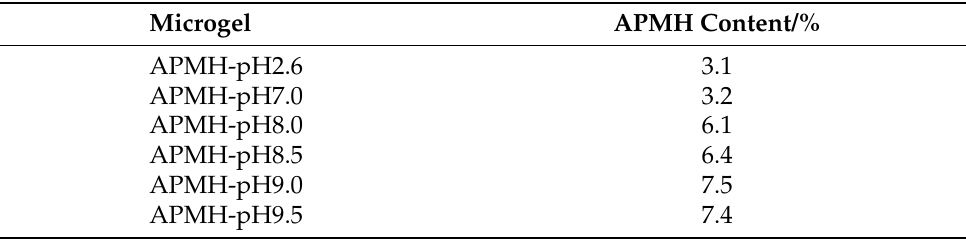
Figure 11. 1 H-NMR spectra of microgel APMH-pH2.6 and -pH9.5 in H 2 O/D 2 O. With increasing pH, a change in APMH-signals is visible. All spectra are given in the Supplementary Material. Table 4. APMH content in the microgels relative to the amount of NIPAM, measured by 1 H-NMR spectroscopy. The nominal APMH-feed was 10mol% in all